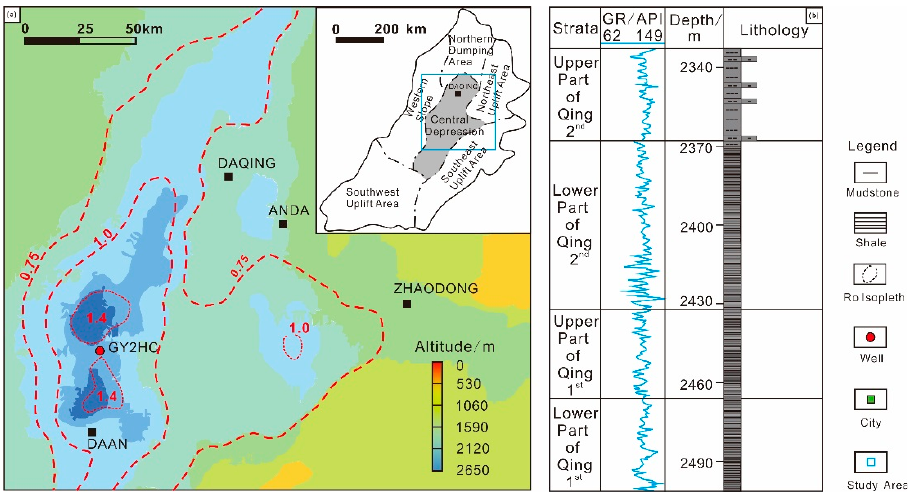
Figure 1. Geological overview of the study area. ( a ) Tectonic unit of the Songliao Basin and the location of the study area; ( b ) lithological column map of the Gulong 3HC well logs [2].